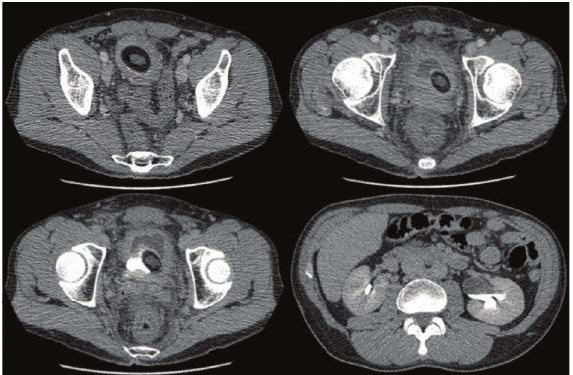
Figure 1: CT scan of the pelvis, demonstrating the toilet brush and surrounding fluid. There is a left-sided hydronephrosis (right, lower picture).